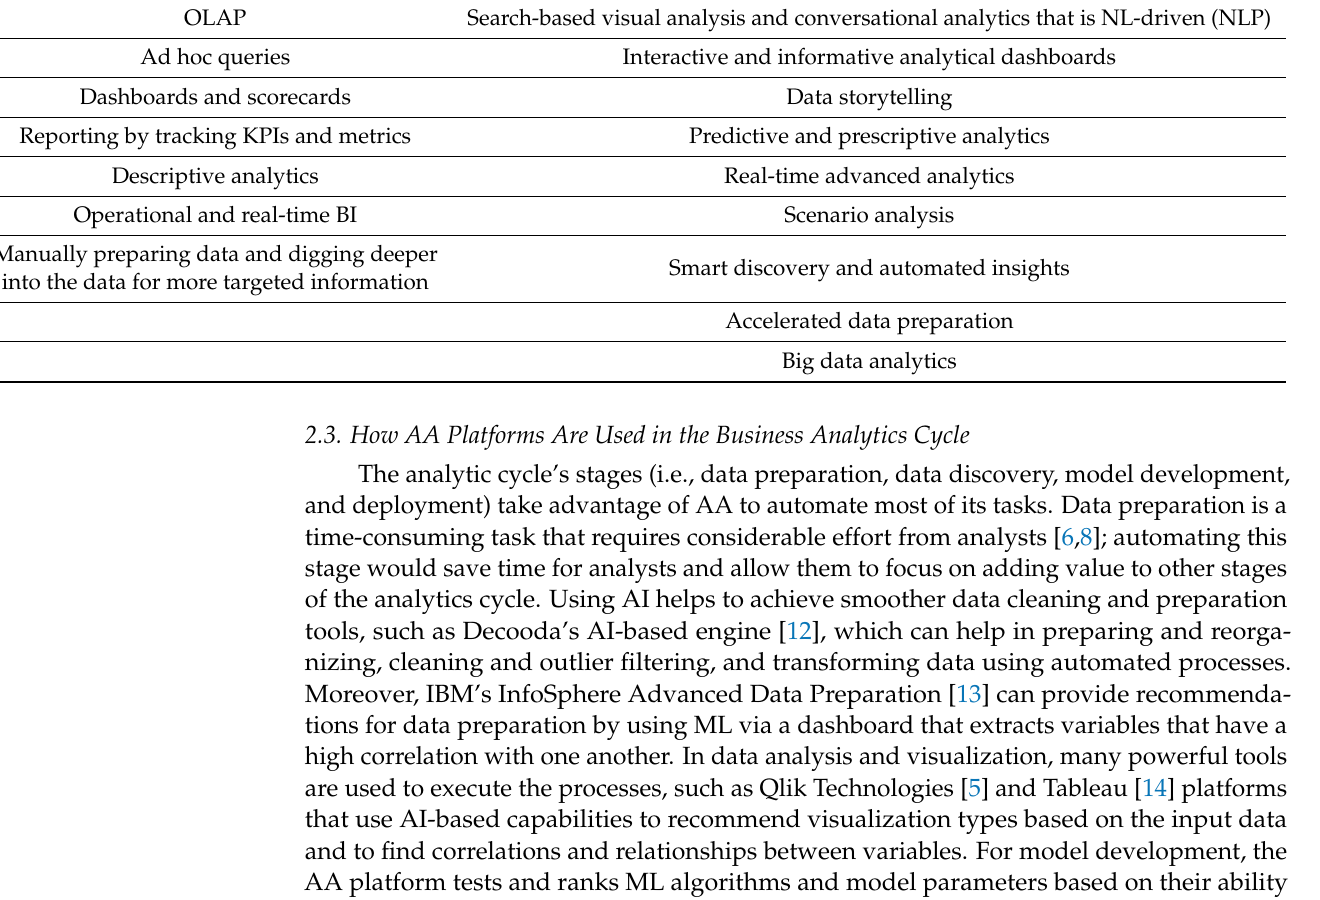
Interactive and informative analytical